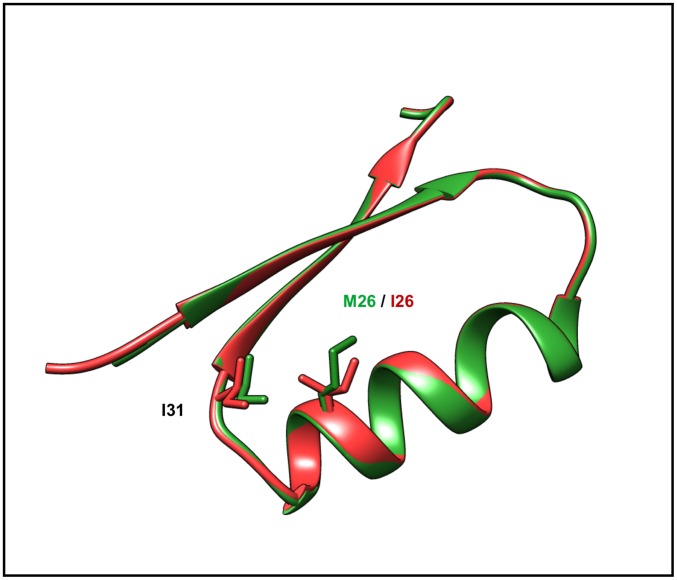
SNV that affects protein structure stability.Disease causing mutation site in protein DJ-1. The wild-type structure (PDB: 1P5F) is depicted in green and the variant (PDB: 2RK4) in red. M26 is a conserved residue in Alpha_helix A located within the hydrophobic core of the protein. The steric clash between I26 and the sidechain of I31 results in a ~0.7 Å displacement of I31 away from I26, resulting in loss of favorable packing contacts involving M26.